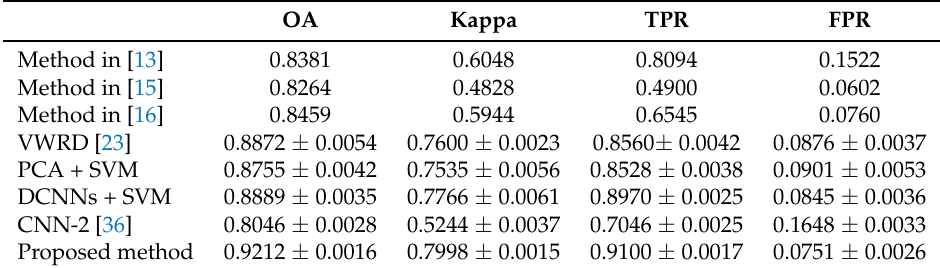
Table 6. Average performances of different methods using the DigitalGlobe